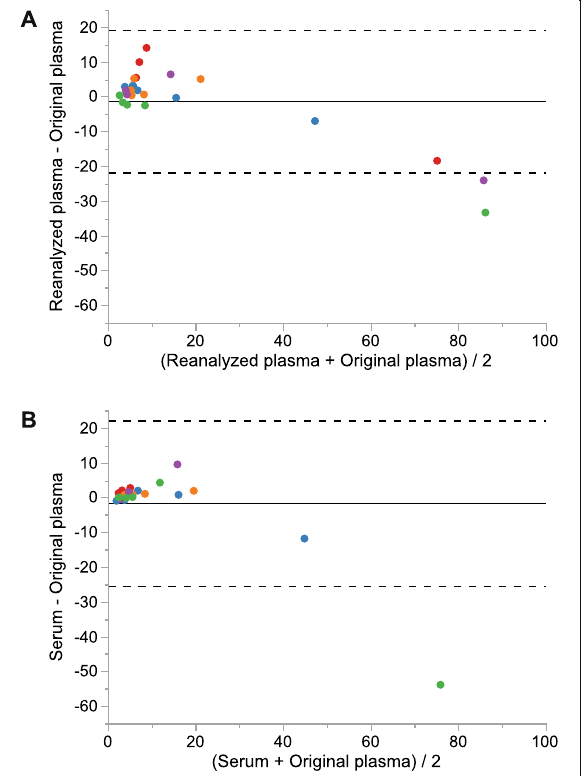
Fig. 2 Bland – Altman scatter plot of difference between previously analyzed plasma and reanalyzed plasma ( a ) and previously analyzed plasma and serum ( b ) against the average of the two measurements. Samples from individual patients are color